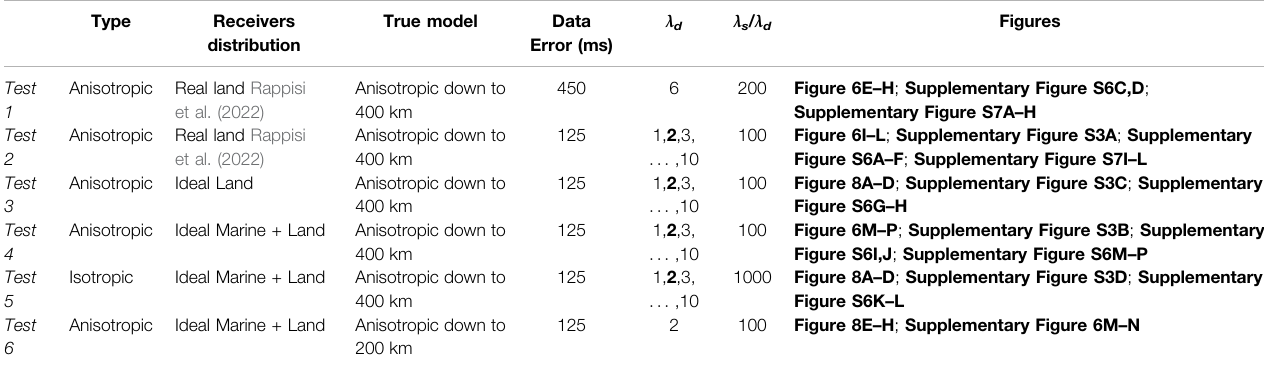
TABLE 1 | Inversions summary table. The type of inversion (isotropic/anisotropic), receivers distribution, true model, standard deviation of normally distributed data errors, damping and smoothing factors and relevant fi gures for each inversion are listed. In bold the λ d corresponding to the preferred solution.